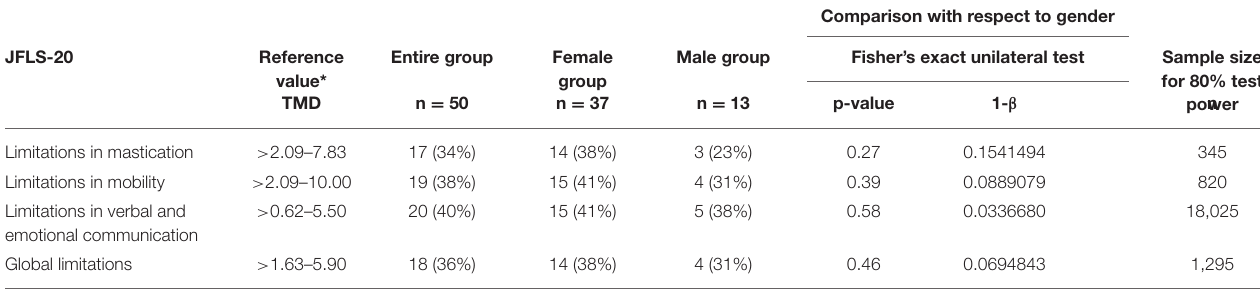
TABLE 3 | The prevalence of limitations in mastication, mobility, verbal, and emotional communication and global restrictions with respect to JFLS-20 in the entire group (n = 50), the female group (n = 37) and the male group (n = 13).